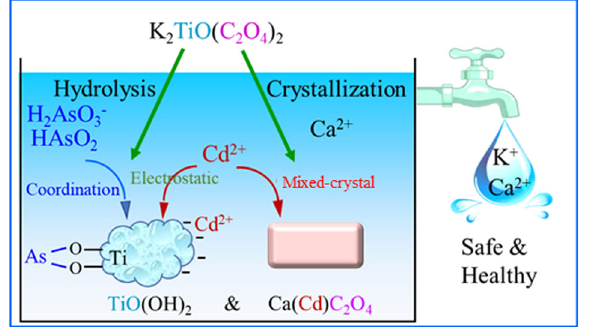
Fig. 8 Proposed mechanism for the coprecipitation of As and Cd using K 2 TiO(C 2 O 4 ) 2 coagulation.